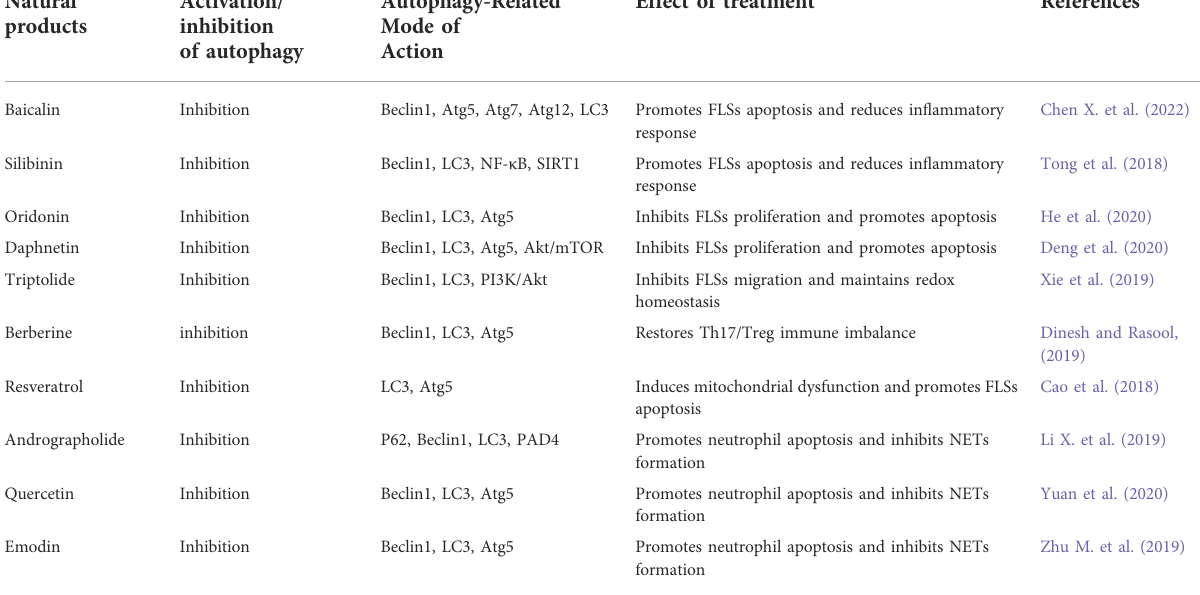
TABLE 2 Natural products for the treatment of RA by targeting